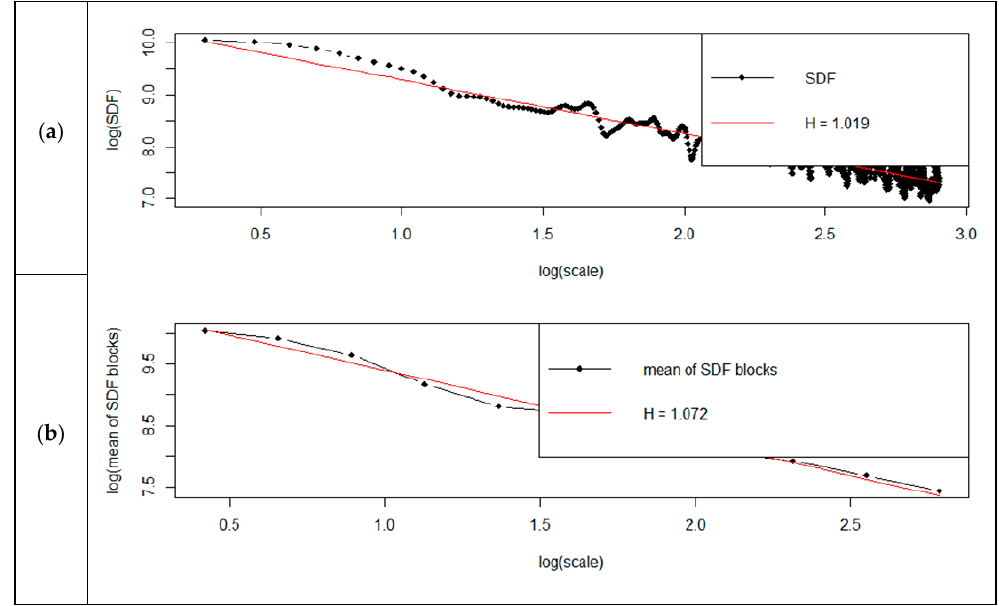
Figure 7. Spectral regression graph by Welch method: ( a ) the standard method, ( b ) the smoothed method.